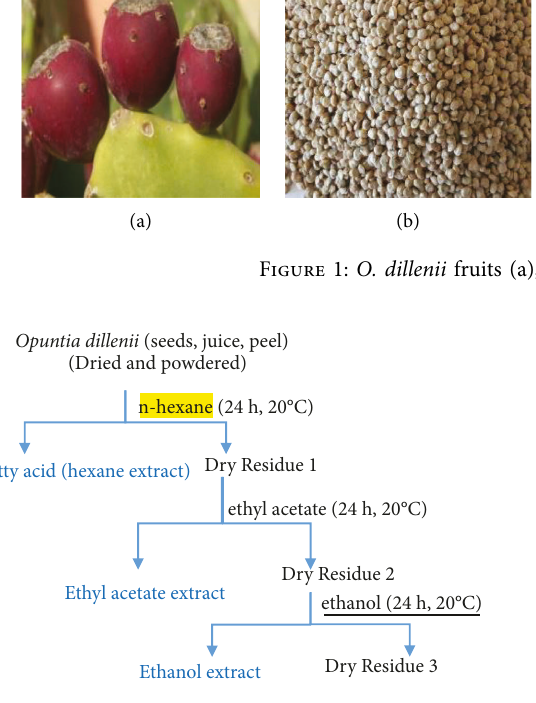
Figure 2: Maceration extraction